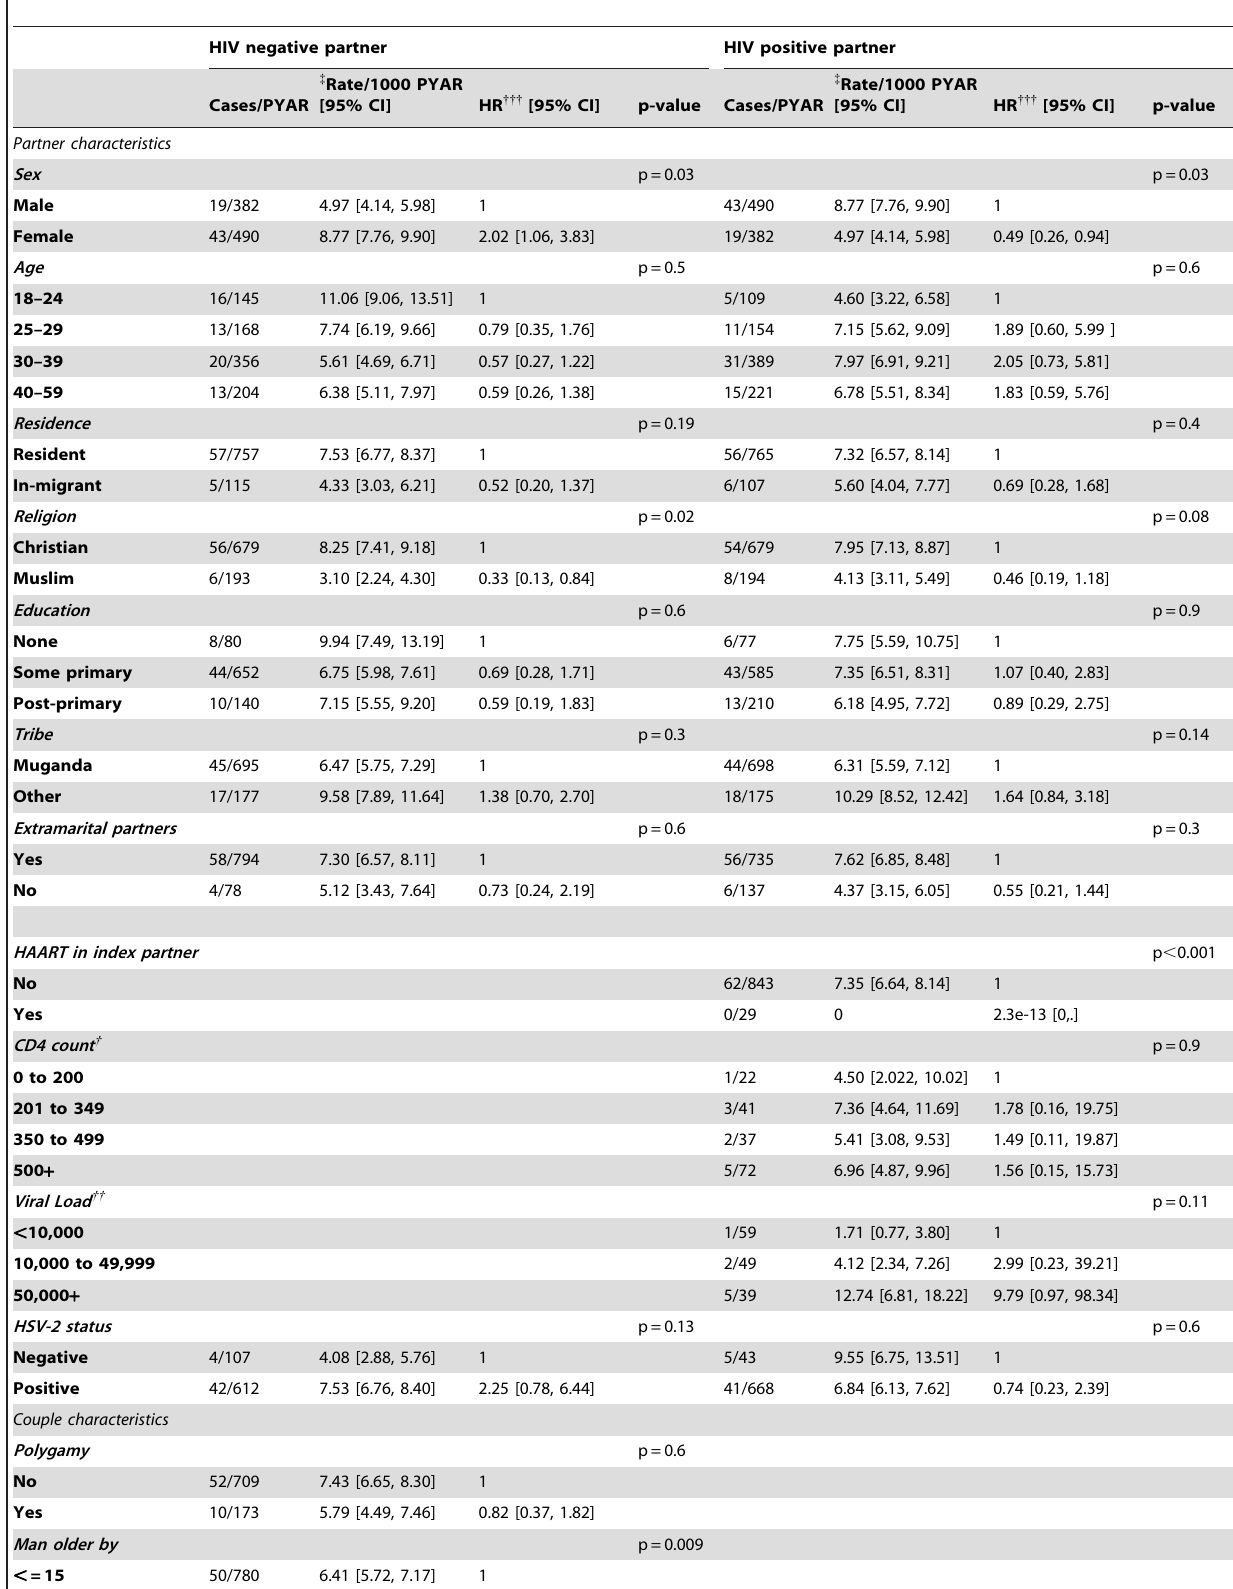
Table 1. Rates of HIV seroconversion and transmission among HIV serodiscordant couples and crude hazard ratios for effect of partners’